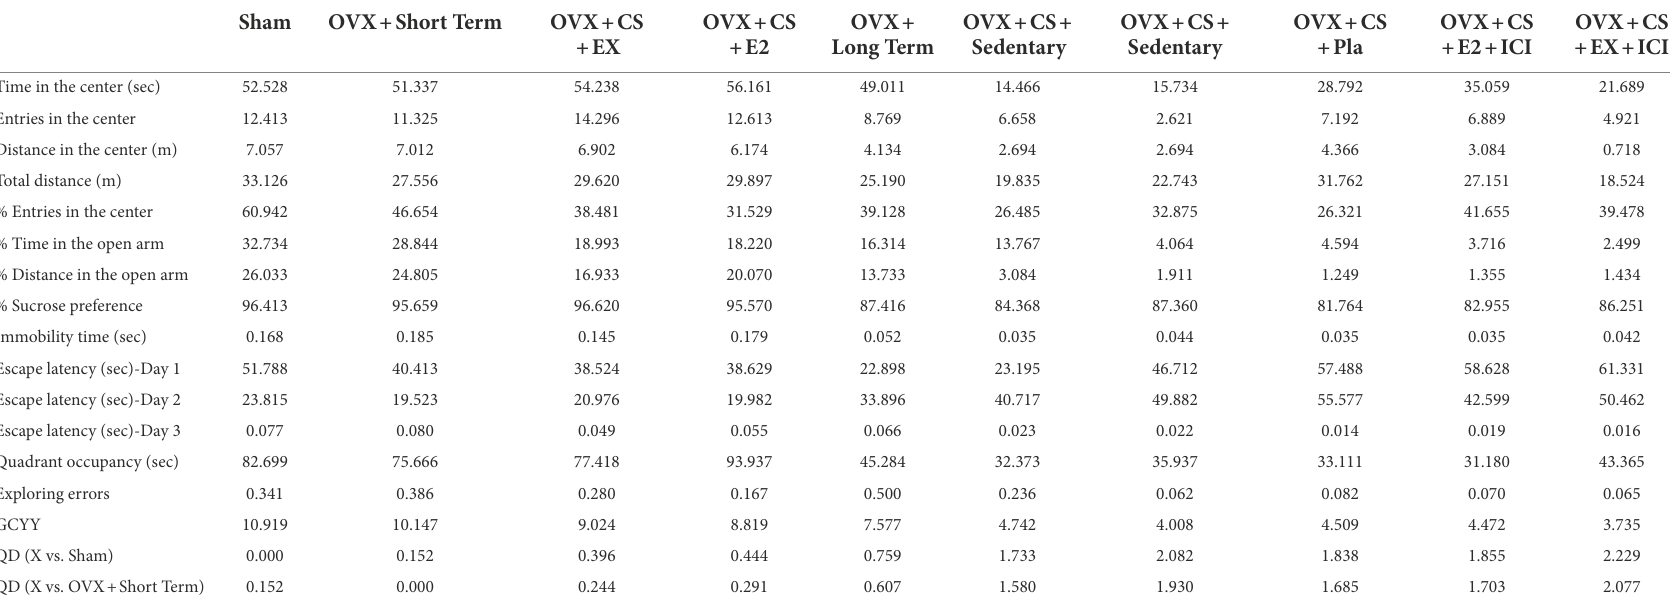
TABLE 1 Quantitative difference statistics for the geometric mean of all behavioral